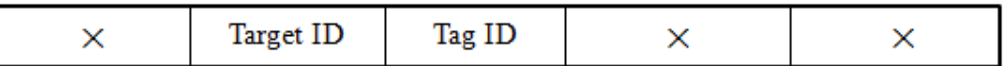
Figure 3. RFID tag’s signal format after association with a